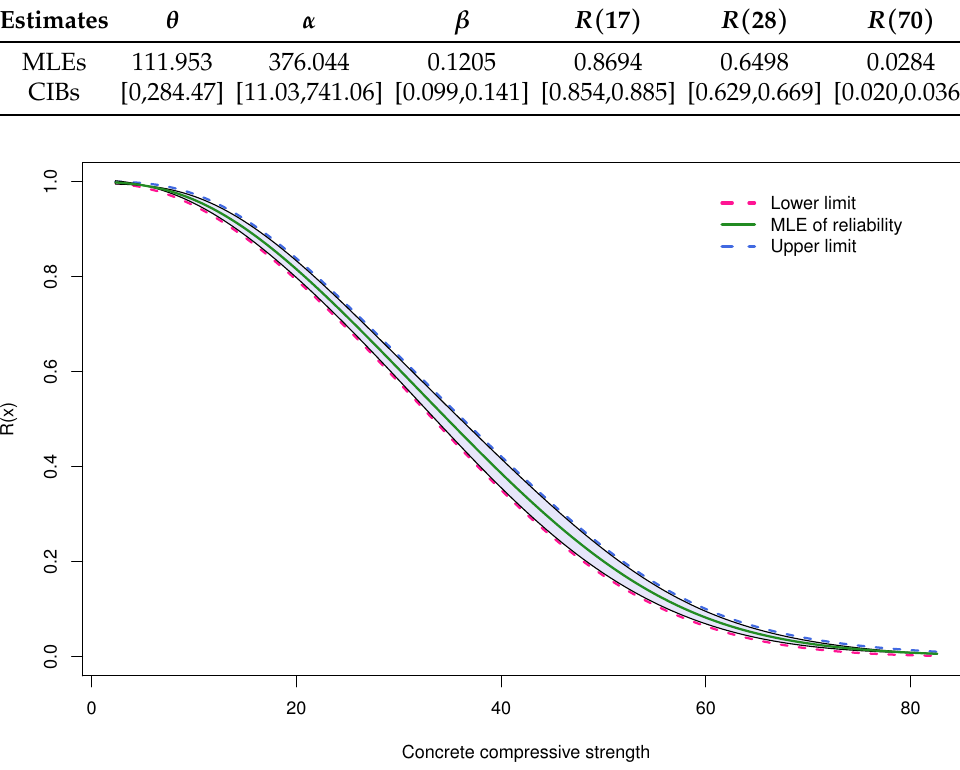
Table 10. MLEs and the CIBs (in parentheses) for the concrete compressive strength data.